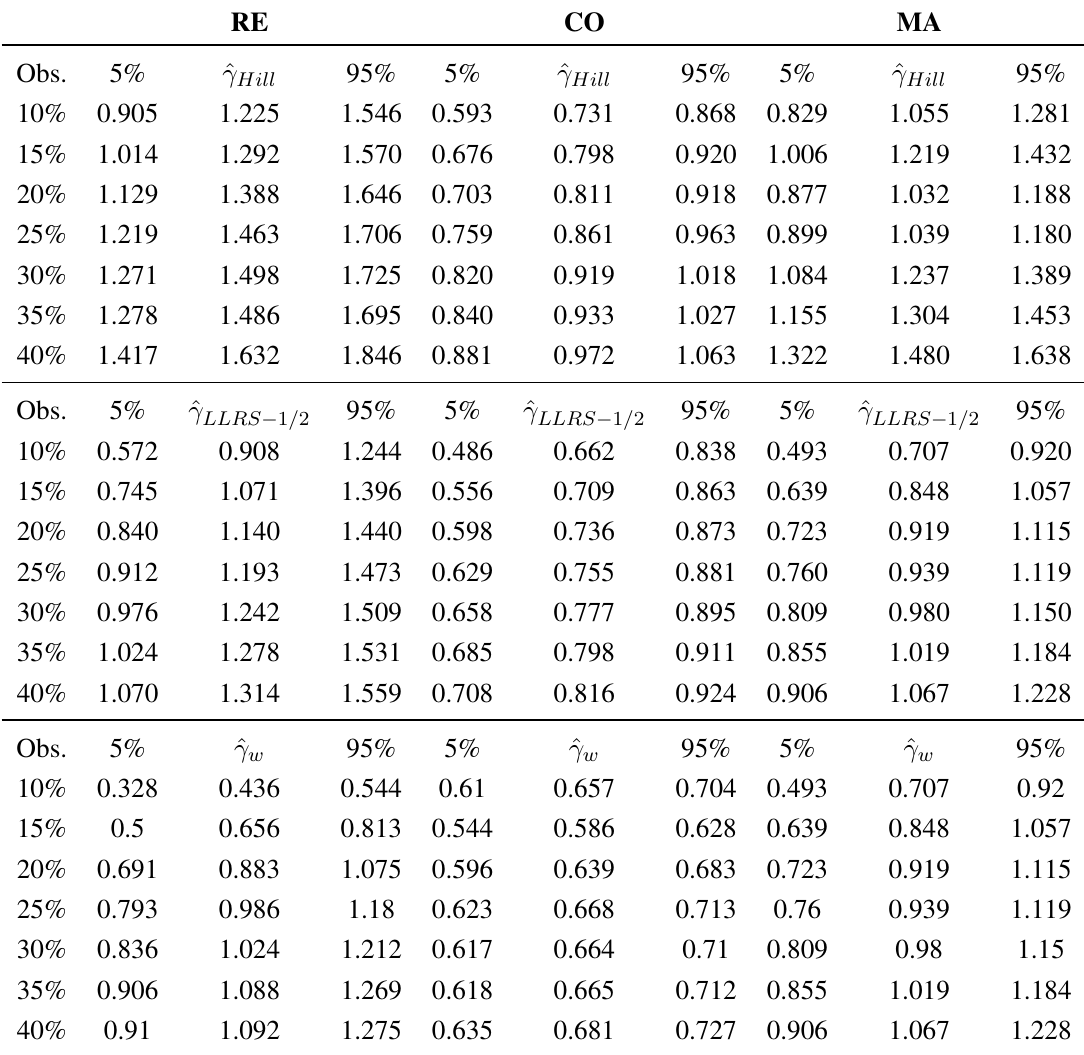
given in Equation w